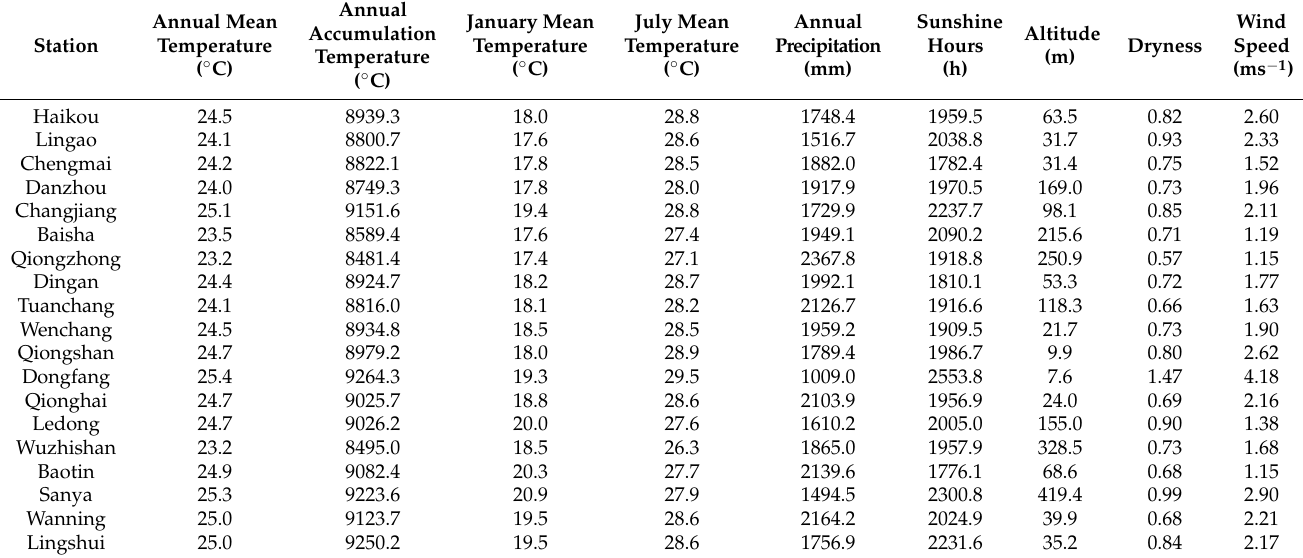
Table 1. Characteristics of meteorological elements in main cities and counties of green orange